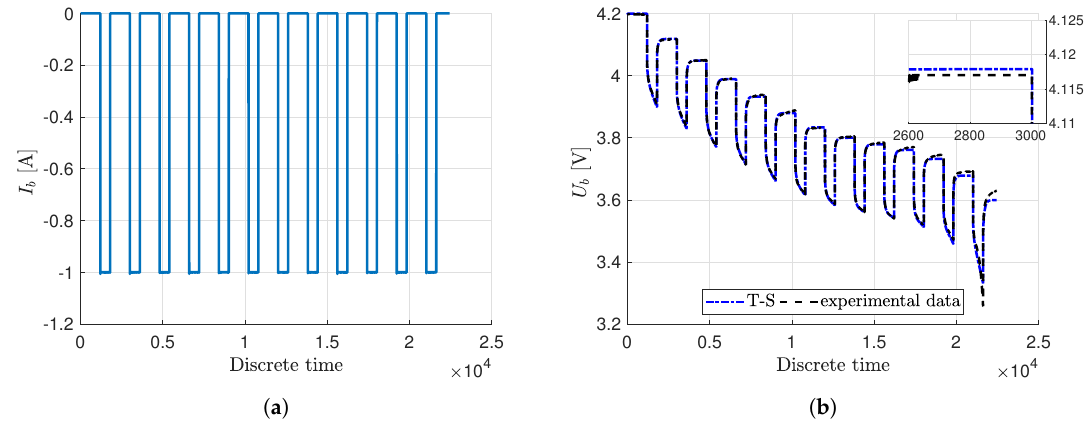
Figure 3. Input vector ( a ) and comparison between experimental data and the T-S system for the battery voltage U b ( b ).